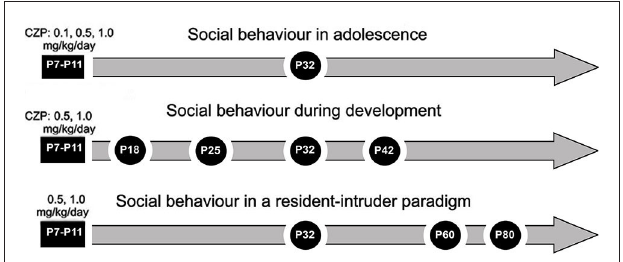
FIGURE 1 | Design/time diagram of experimental procedure: social behavior in adolescence, social behavior during development and social behavior in a resident-intruder paradigm . The upper part shows a timeline for the Experiment 1: social behavior in adolescence after 0.1, 0.5 and 1.0 mg/kg/day of CZP exposure between P7 and P11. The middle part shows a timeline for the Experiment 2: social behavior during development after 0.5 and 1.0 mg/kg/day of CZP exposure. The lower part shows a timeline for the Experiment 3: social behavior in a resident-intruder paradigm